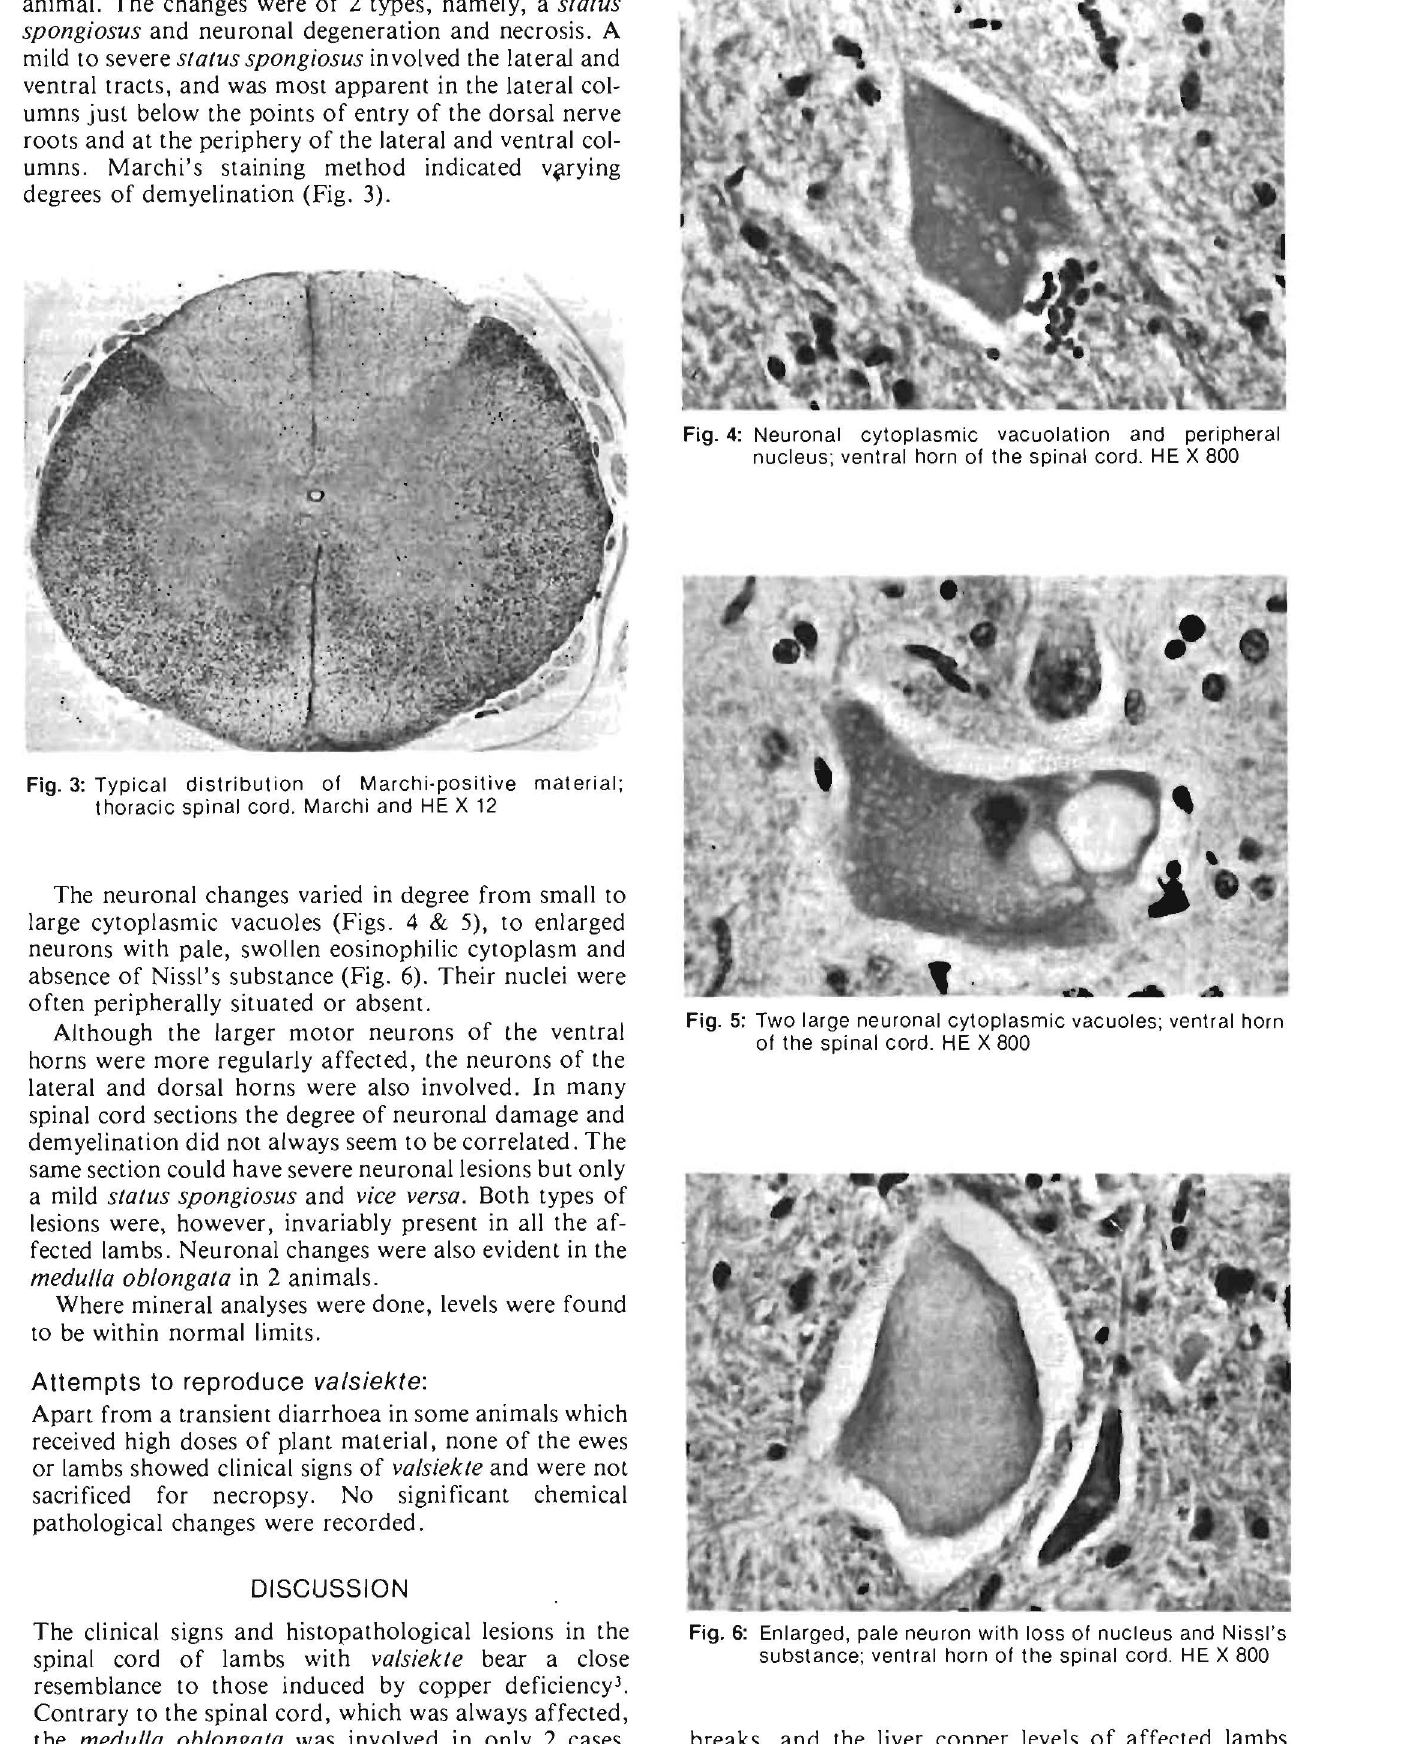
breaks, and the liver copper levels of affected lambs were always within normal limits. The districts where valsiekte occurs are known to be associated with chronic copper poisoning i in